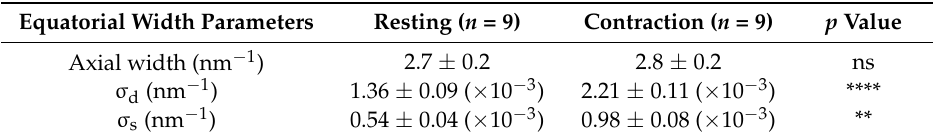
Table 1. Peak width parameters for the equatorial reflections in resting and normal contracting